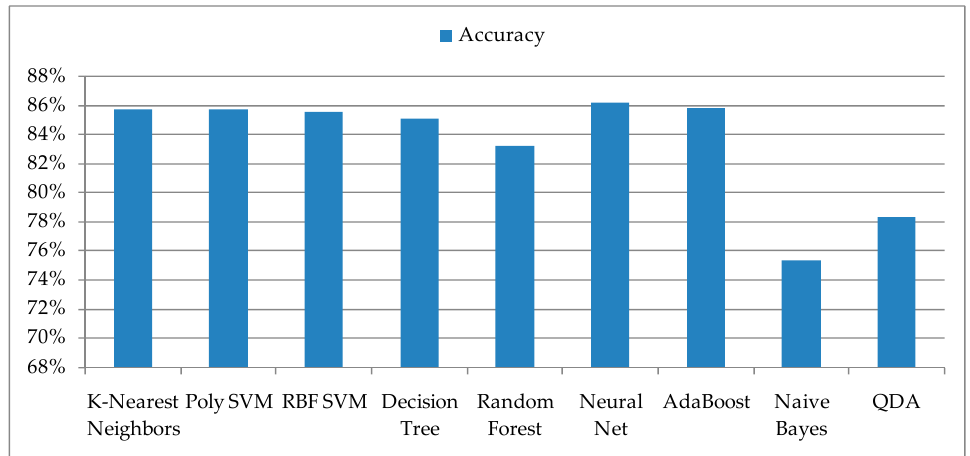
Figure 1. Accuracy of the used ML algorithms.